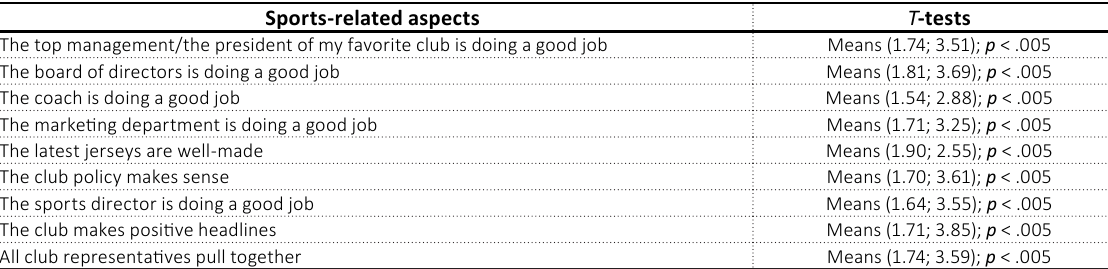
Table 5. Results of T -tests concerning sports-related aspects